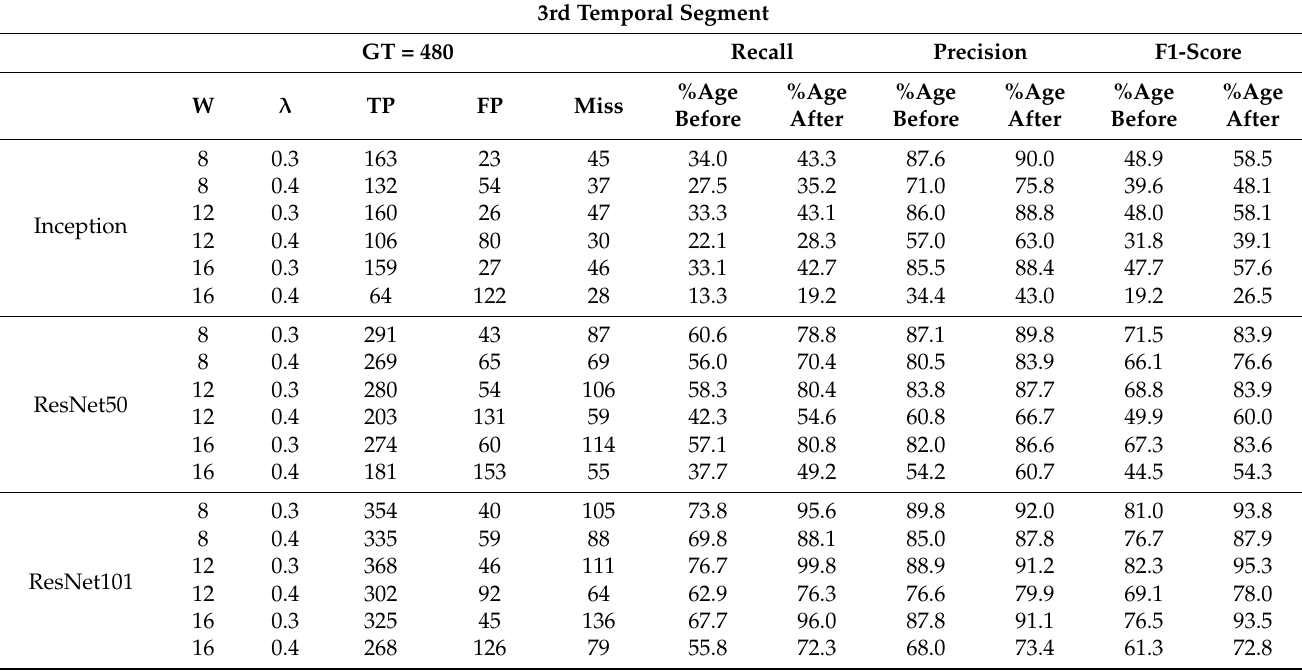
Table A4. Detections and refinement results of 3rd temporal